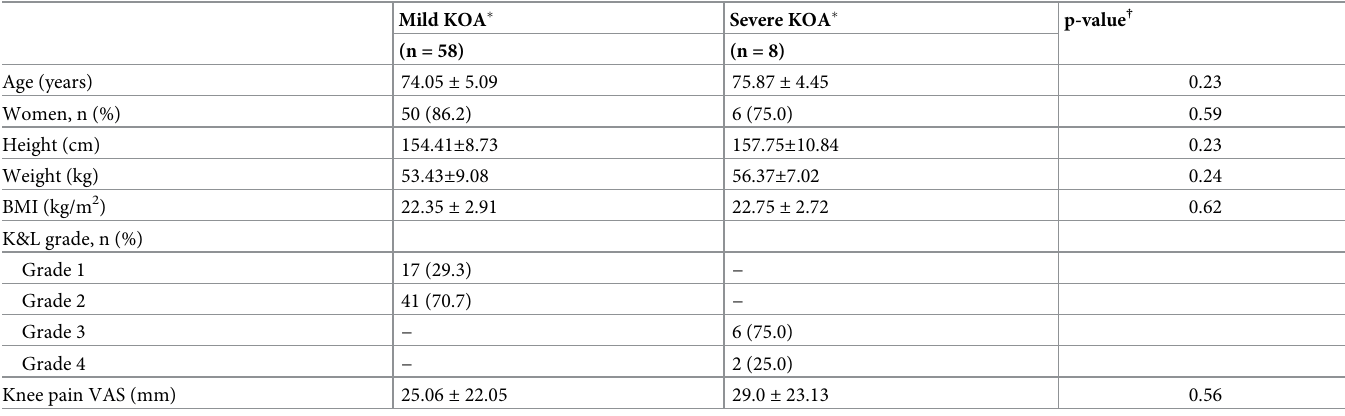
Table 1. Characteristics of participants with mild and severe